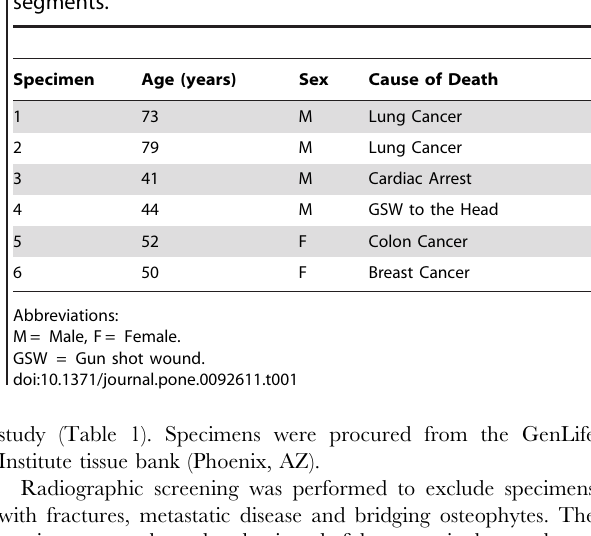
Table 1. Specimen demographics for six lumbar spine segments.